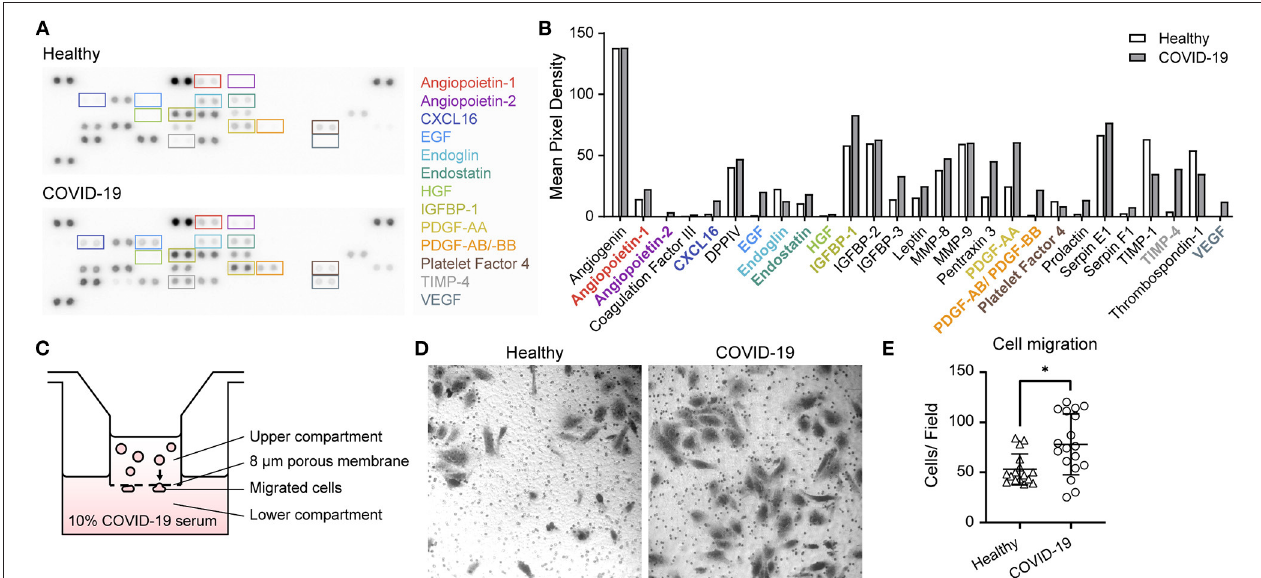
FIGURE 4 | Proteome profiler array and cell migration induced by coronavirus disease 2019 blood serum. (A) Representative image of the angiogenic proteome profiler array using blood serum samples from healthy participants and from those with severe COVID-19. (B) Quantification of pixel mean density of each angiogenesis-related protein. (C) Schematics of Transwell Boyden chamber assay using blood serum samples from COVID-19-infected and healthy participants in the lower compartment as chemoattractants. (D) Representative images of migrated endothelial EA.hy926 cells induced by blood serum samples of COVID-19-infected and healthy participants. (E) Quantification of migrated cells by field ( n = 5 healthy individuals, n = 3 severe, n = 1 critical, and n = 1 non-surviving COVID-19 patient) using both samples in first 24h and on the 10th day of hospitalisation. Statistical significance ( P -values) is obtained using Mann–Whitney * P <